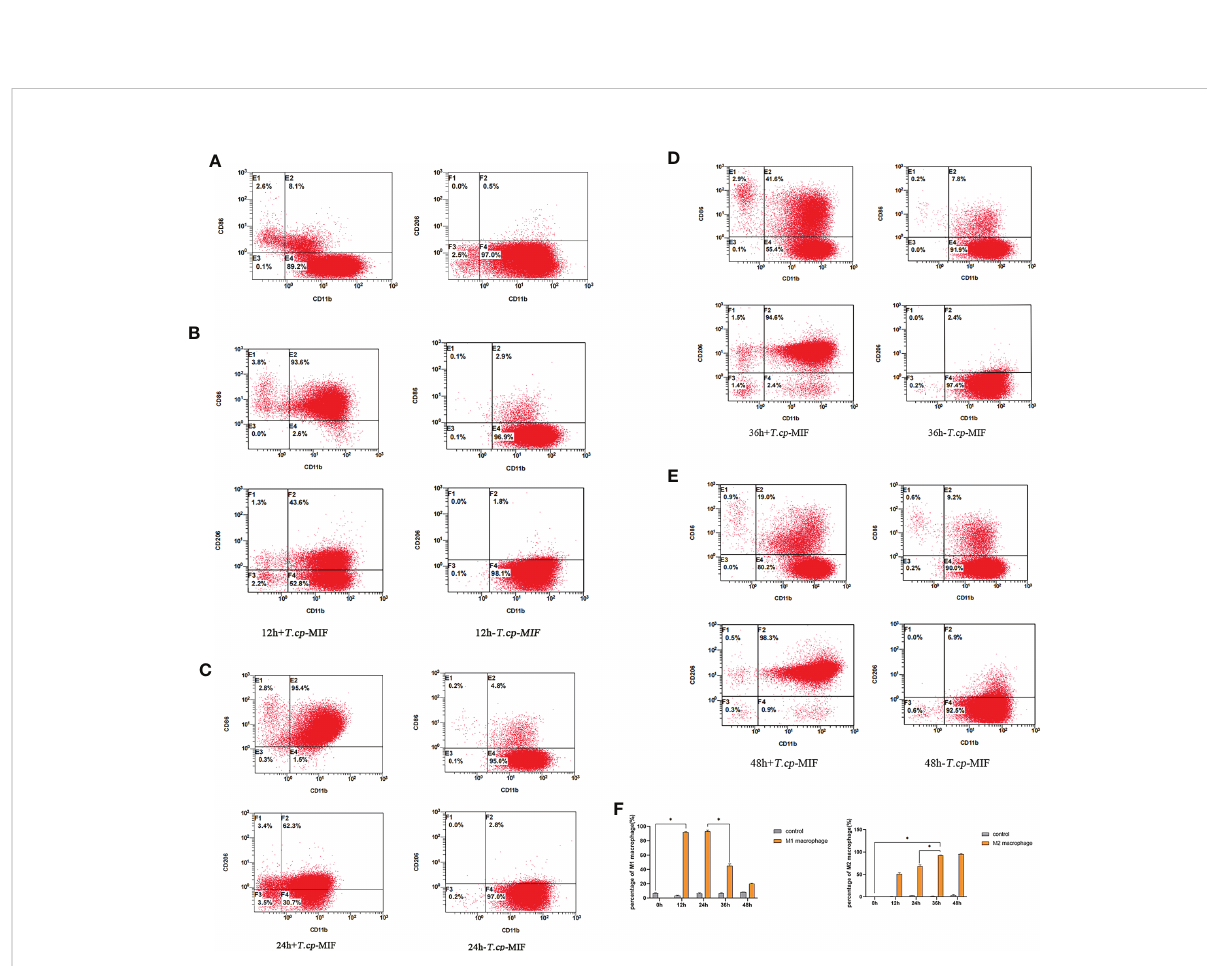
FIGURE 3 3 The expression of phenotype molecules in M1 and M2 macrophage at different time. (A – E) Cell fl ow plots. (A) Double positive rate of CD11b, CD86, CD11b and CD206 in M0 type macrophages after PMA induction. (B) The double positive rate of CD11b and CD86 after 12 h of T.cp -MIF induction was 93.6% indicating that M0 changed to M1 type macrophages under T.cp -MIF induction. (C) The double positive rate of CD11b and CD86 was 95.4% in 24 h+ T.cp -MIF group, indicating that the macrophage was still M1 type at 24 h. (D) The double positive rate of CD11b and CD206 after 36 h of T.cp -MIF induction was 94.6% indicating that M1 changed to M2 type macrophages under T.cp -MIF induction. (E) The double positive rate of CD11b and CD206 was 98.3% in 48 h+ T.cp -MIF group, indicating that the macrophage was still M2 type at 48 h. (F) Results are showed as the mean of three times of independent experiments ( x ̄ ± SD, n=3) * indicated P